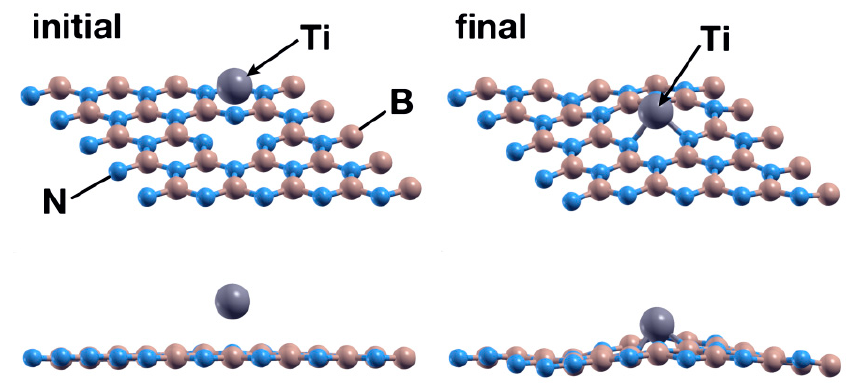
Figure 4. Initial ( left ) and final ( right ) configurations of the FPMD calculation for the first case considered. The upper images show a perspective view of the system, while the lower images show a picture of the XZ plane. The titanium atom is chemisorbed by the hBN surface with a B vacancy, occupying the vacancy.